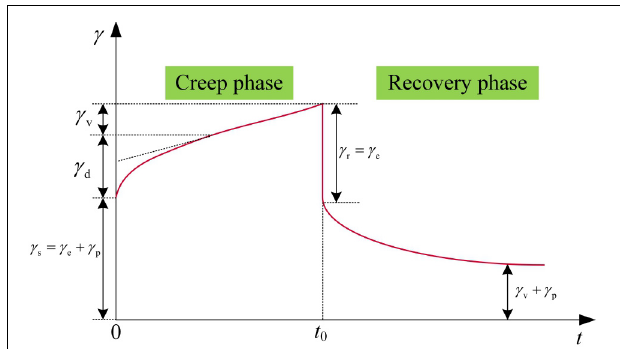
FIGURE 3 | Creep and recovery behavior of nonlinear viscoelastic